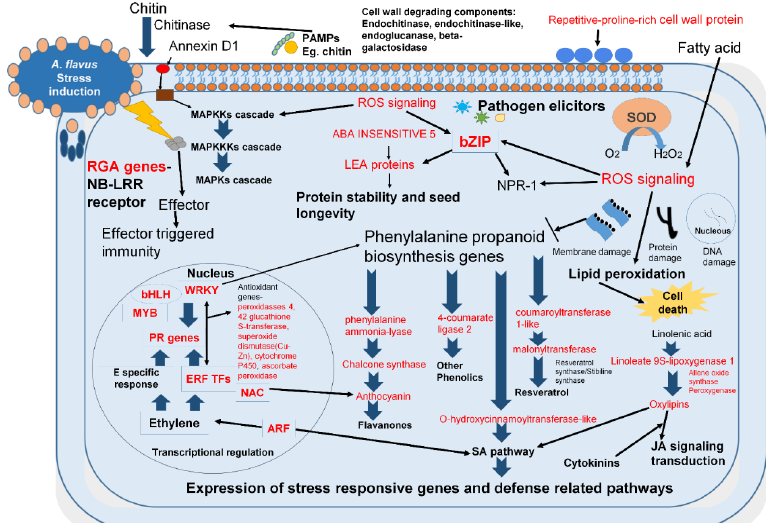
Figure 4. Representation of genes/pathways/transcription factors identified from host–pathogen interaction during aflatoxin production. This pathway has added an understanding of gene regulation and regulatory networks at the gene expression